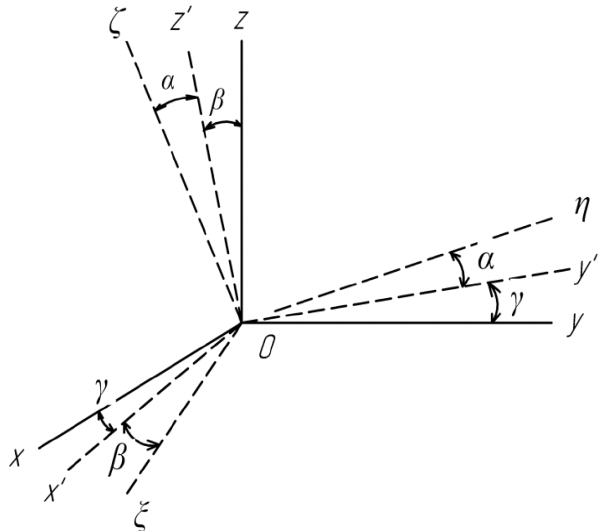
Figure 3. Sequence of turns of the output link. According to the linear accuracy theory, the increment in the drives is zero, where δφ 11 = δφ 21 = δφ 31 = 0.